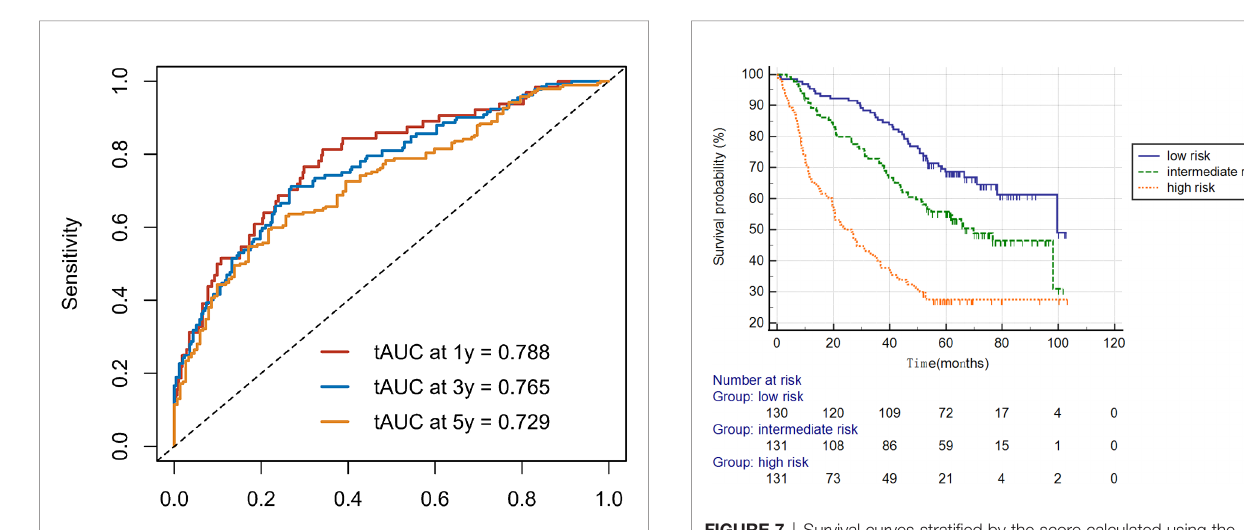
FIGURE 7 | Survival curves strati fi ed by the score calculated using the nomogram in the training cohort (low risk: < 30; intermediate risk: 30 – 50; and high risk: >